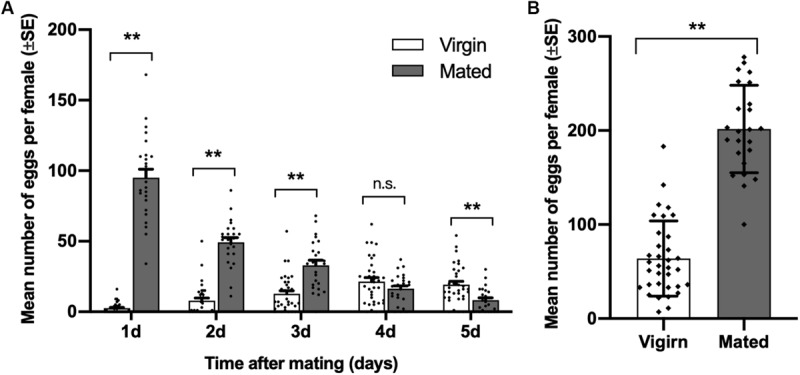
Effect of mating on female oviposition by Plutella xylostella. (A) Number of eggs laid by virgins (n = 34) and mated females (n = 24) one to 5 days after mating. (B) Total number of eggs laid by virgins (n = 34) and mated females (n = 24) for 5 days after mating. Individual data is displayed with dots. **indicates a significant difference (p < 0.01, Student’s t-test).